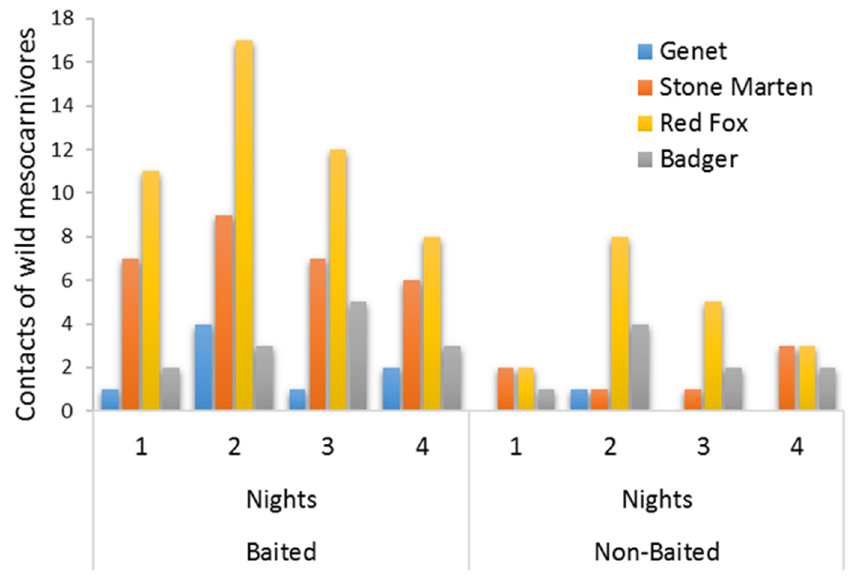
Figure 2. Frequency of occurrence (independent contacts) of wild mesocarnivores along the four nights of camera exposure in baited and non-baited stations.